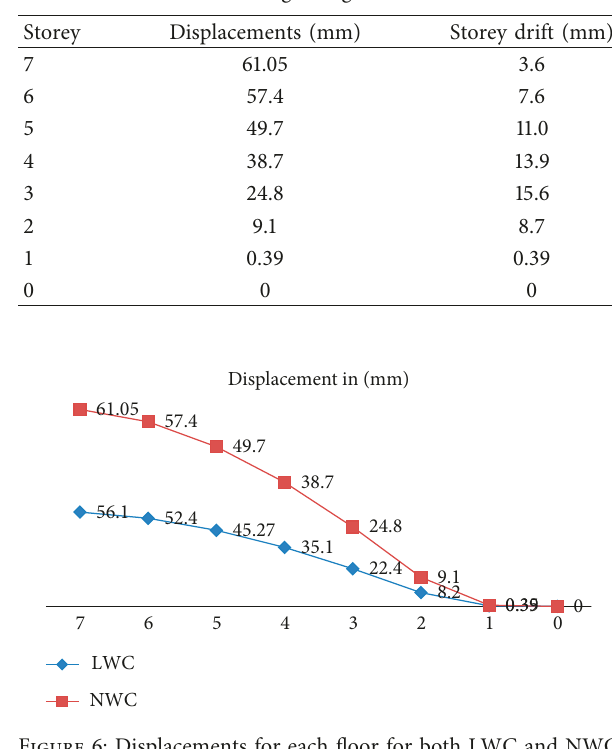
Table 8: Lightweight concrete.